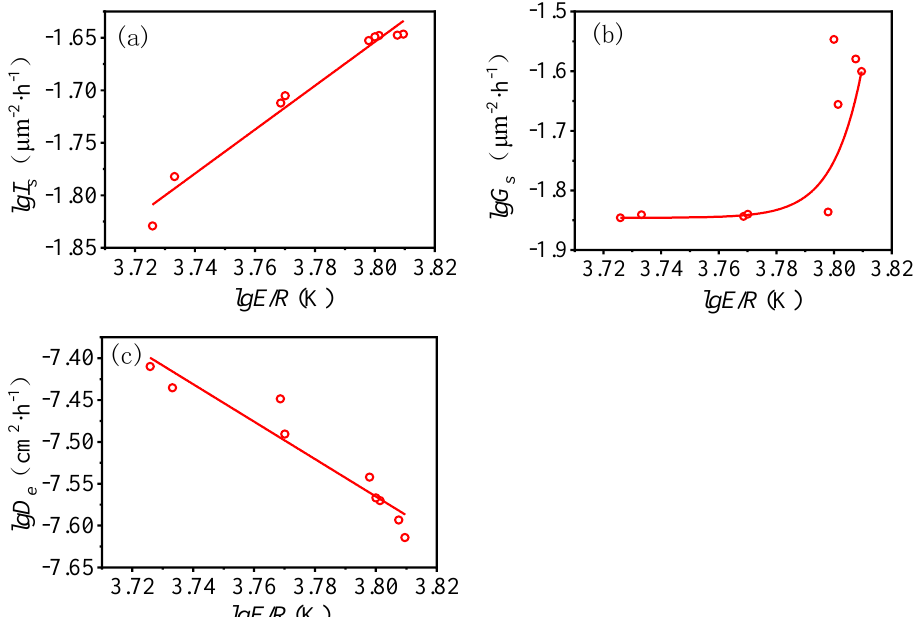
Figure 6. The relationship of hydration kinetics parameters between apparent activation energy and ( a ) I s , ( b ) G s and ( c ) D e , respectively.